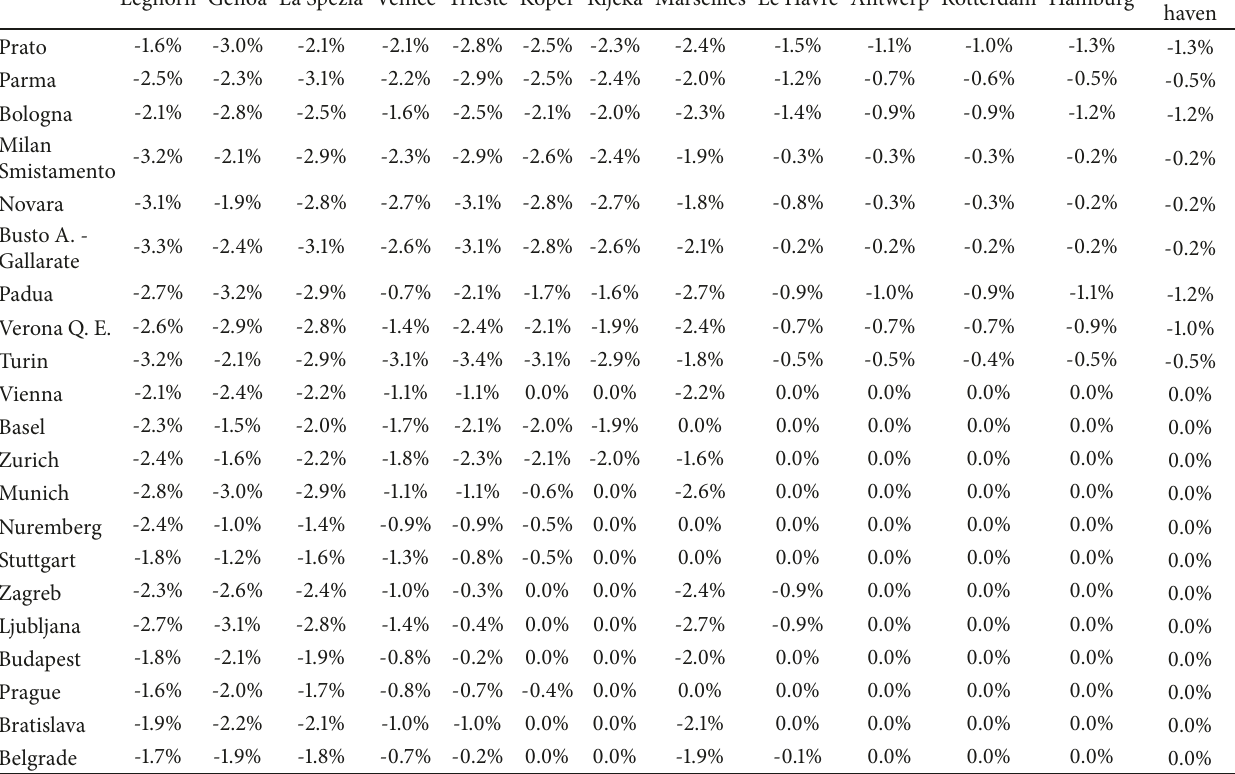
Table 9: Differences, in percentage of monetary costs, between monetary costs of the first sensitivity scenario and monetary costs of the current scenario (the current scenario is taken as